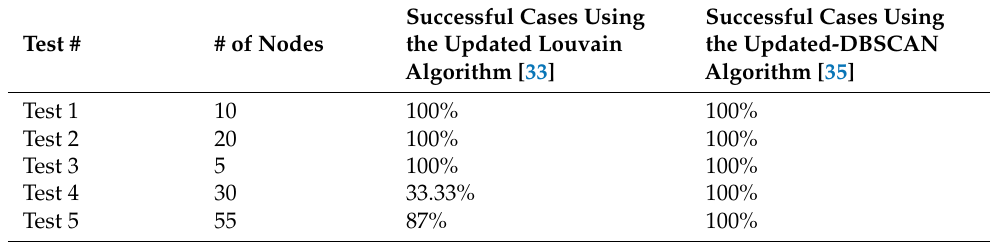
Figure 10. Test 5, testing many printers using the Updated-DBSCAN algorithm. Table 3. Accuracy based on the number of clusters.